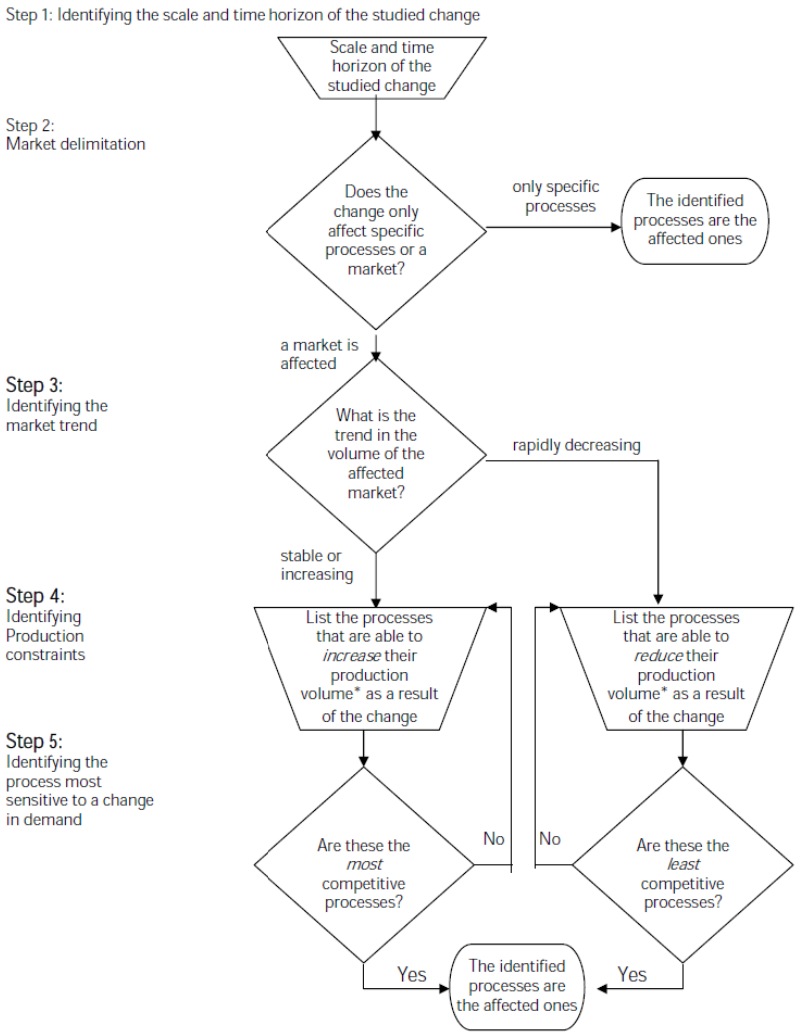
Figure 3. Decision tree outlining the five-step procedure for identifying the processes affected by a change in demand for a specific intermediate product [82]. (Reproduced with permission from [82],